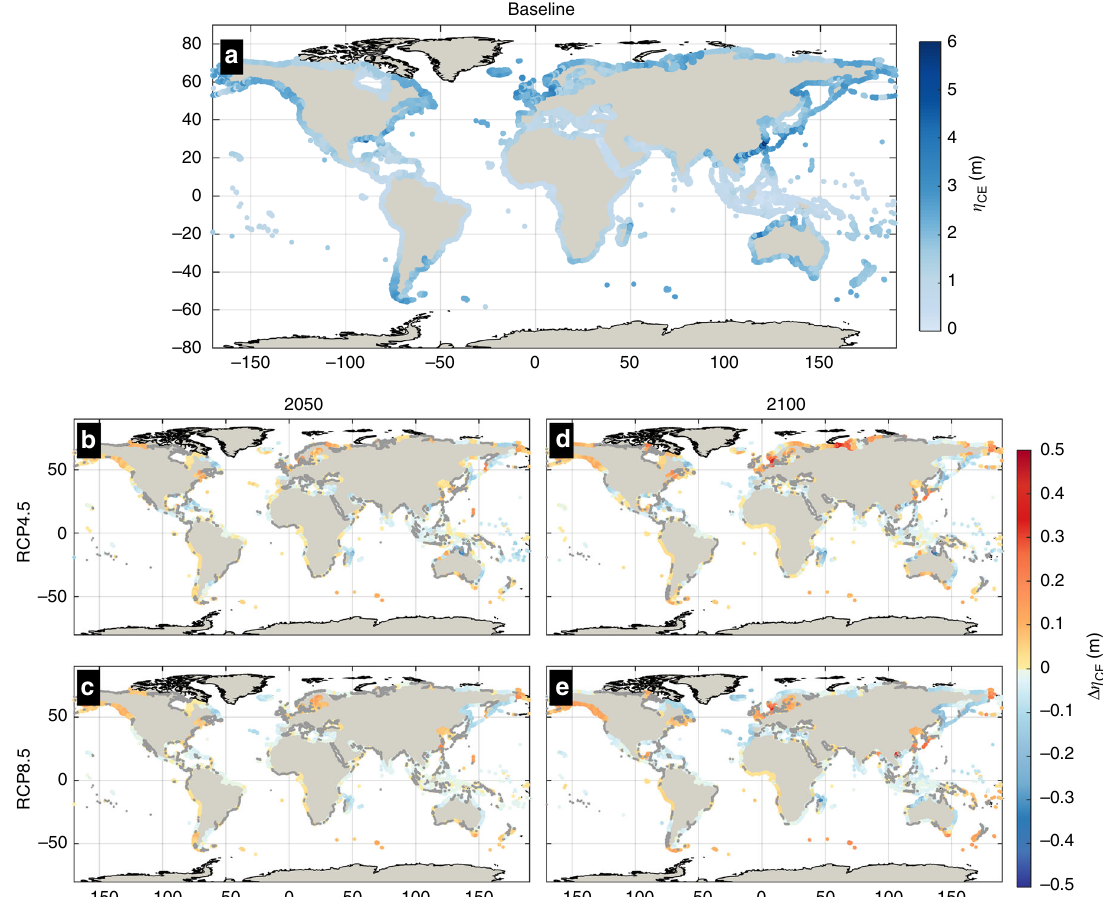
Fig. 3 Present contributions of climate extremes (wind-waves and storm surges) to global ESLs ( η CE ) and projected changes. Maps show the median present-day 100-year η CE ( a ) and projected changes ( Δ η CE ) under RCP4.5 by 2050 ( b ) and 2100 ( c ), and under RCP8.5 by 2050 ( d ) and 2100 ( e ). Warm/ cold colors express an increase/decrease, respectively, while points with high uncertainty are shown in gray (|CV| >